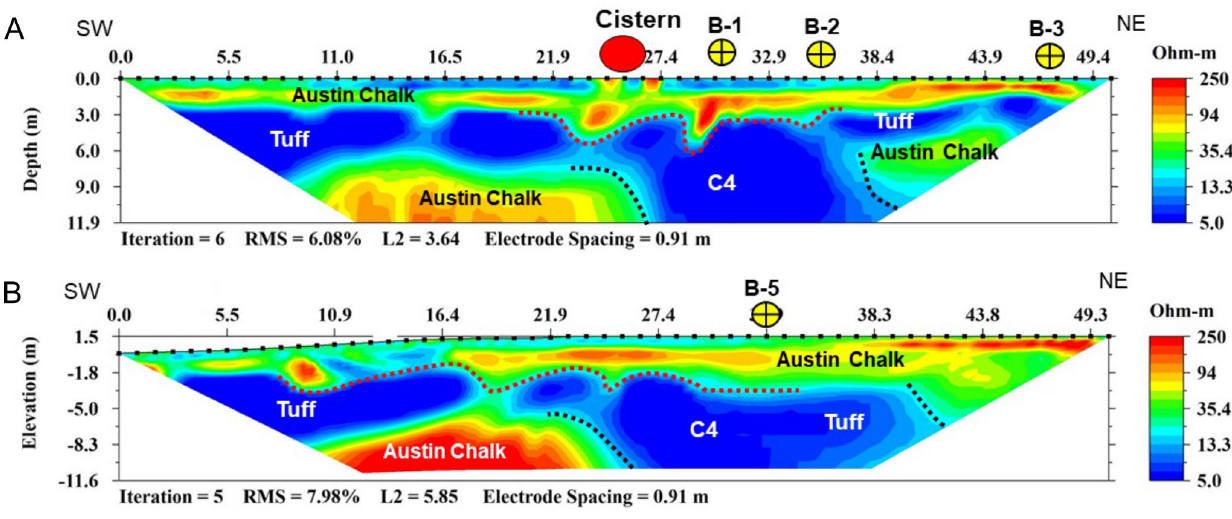
Figure 12: Resistivity data along profiles P8 [A] and P9 [B] at the residential site. Dashed red lines on the resis- tivity profiles indicate the top of tu ff units beneath the Austin Chalk. Dashed black lines indicate the vertical contact on each side of the low resistivity anomaly caused by tu ff